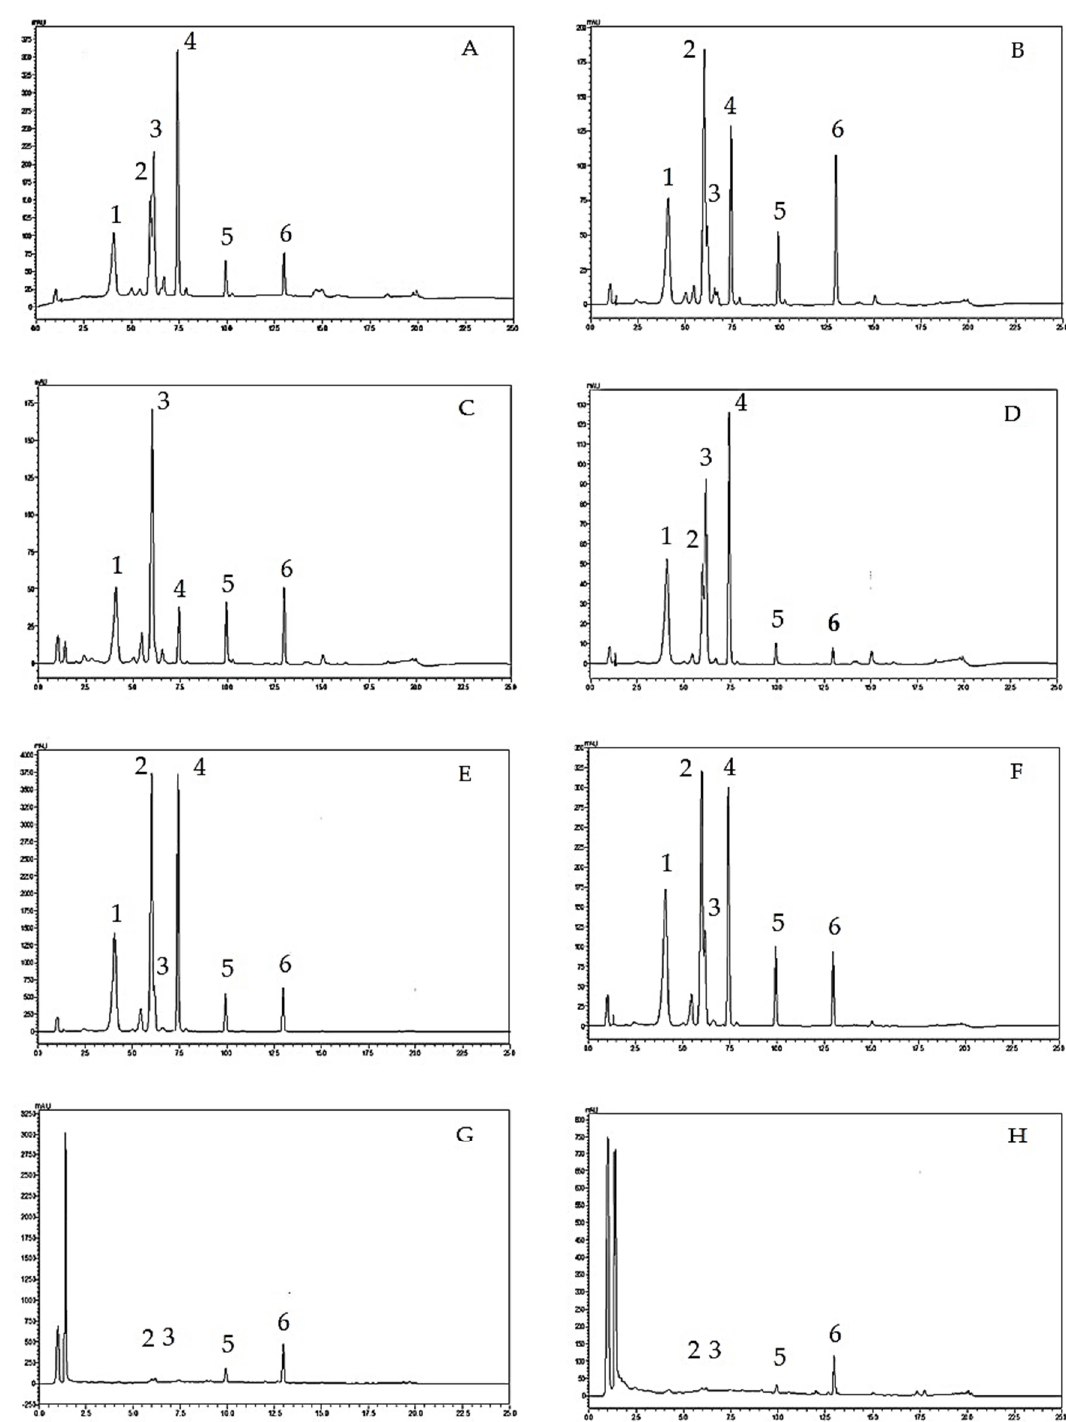
Figure 1. HPLC chromatograms of Oroxylum indicum samples; ( A ) = OIRL(orange-red crystals from O. indicum seed collected from Lampang province), ( B ) = OIYL (yellow precipitates from O. indicum seed collected from Lampang province), ( C ) = OISL ( O. indicum seed extracts from Lampang province), ( D ) (OIRP = orange-red crystals from O. indicum seed collected from Pattani province), ( E ) = OIYP (yellow precipitates from O. indicum seed collected from Pattani province), ( F ) = OISP ( O. indicum seed extracts from Pattani province), ( G ) = OIYF ( O. indicum young fruit extract), and ( H ) = OIFL ( O. indicum flower extract). HPLC peaks; 1 = compound Rt 4, 2 = compound B0, 3 = baicalin, 4 = compound Rt 7, 5 = baicalein, 6 = chrysin.